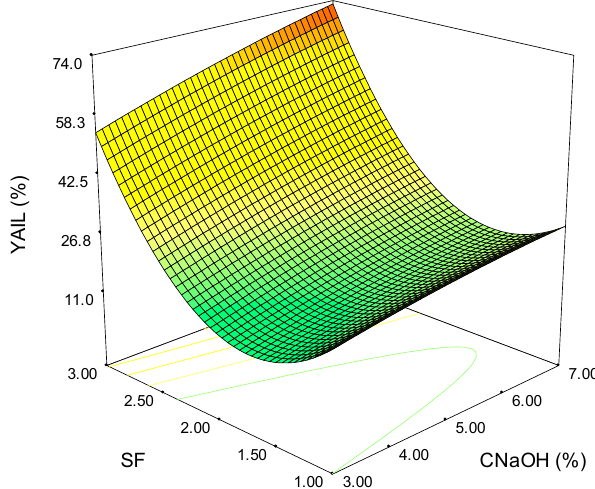
Figure 4. Variation of the acid-insoluble lignin removal yield on severity factor and alkali concentra-